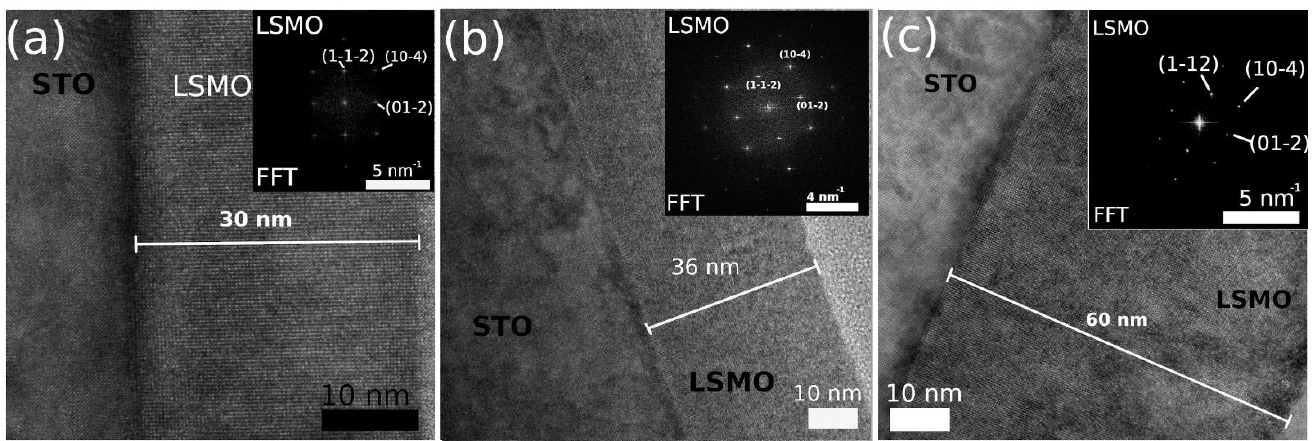
Figure 2. Cross-sectional STEM-DF micrographs of LSMO 30 ( a ), LSMO 36 ( b ), and LSMO 60 ( c ) films grown on the STO substrate. The corresponding Fourier Transform patterns belonging to the LSMO structures are shown in the right side insets of each figure.